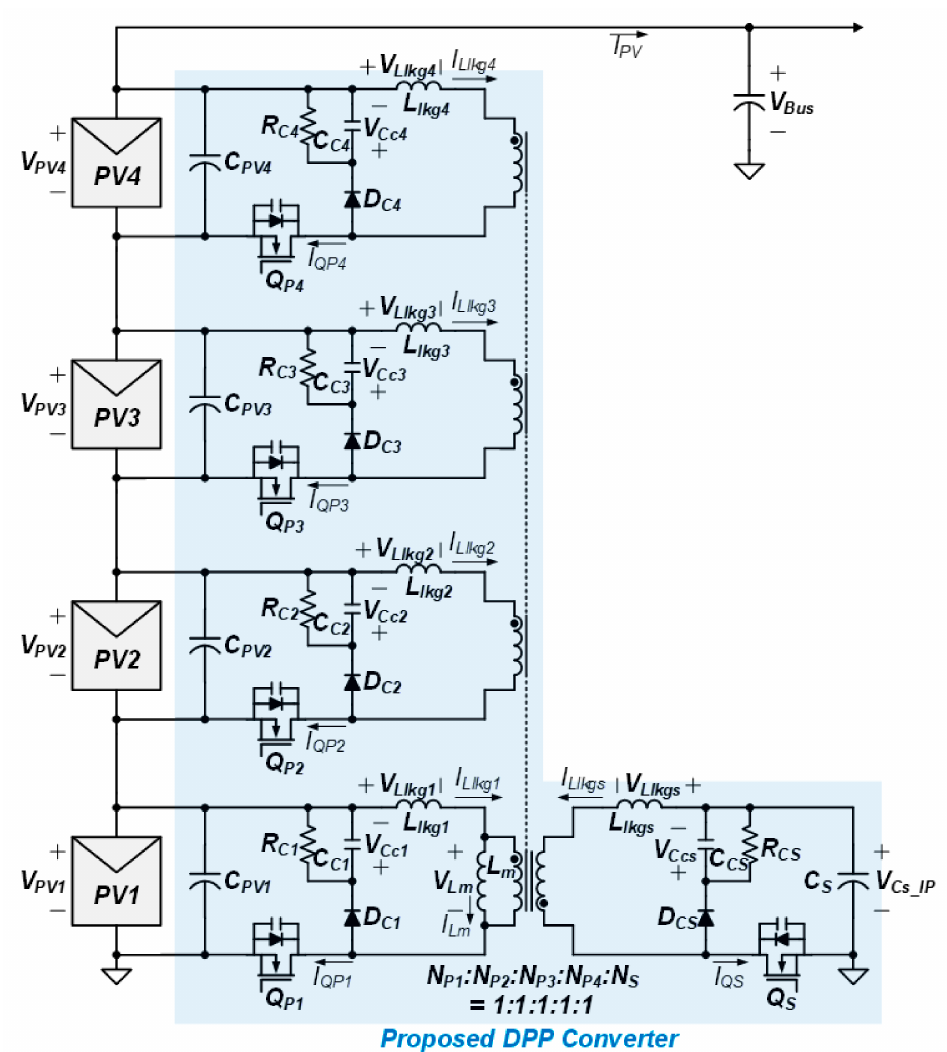
Figure 2. Circuit configuration of the proposed Differential Power Processing converter. Mode 1 ( t 0 – t 1 ): Both Q P1 and Q P2 remain turned on, and the PV1 voltage ( v PV1 (t) ) is greater than the PV2 voltage ( v PV2 (t) ) as mentioned in the above assumptions. Therefore, the voltage applied to the L m ( v Lm (t) ) has a value between v PV1 (t) and v PV2 (t) . As a result, the voltages of L lkg1 and L lkg2 are as shown below.